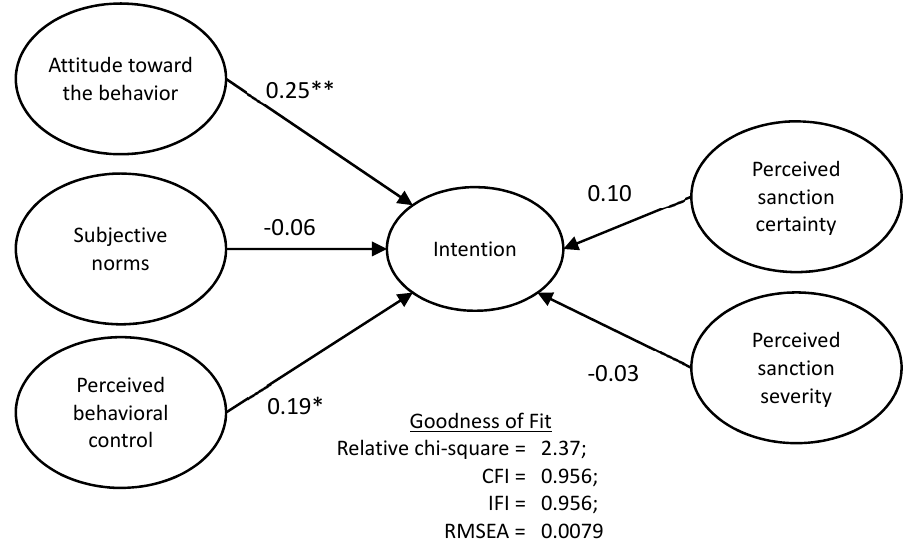
Figure 3. The results of the research model (* p < 0.05, ** p < 0.01). CFI = comparative fit index; IFI = incremental fit index; RMSEA = root mean squared error of approximation